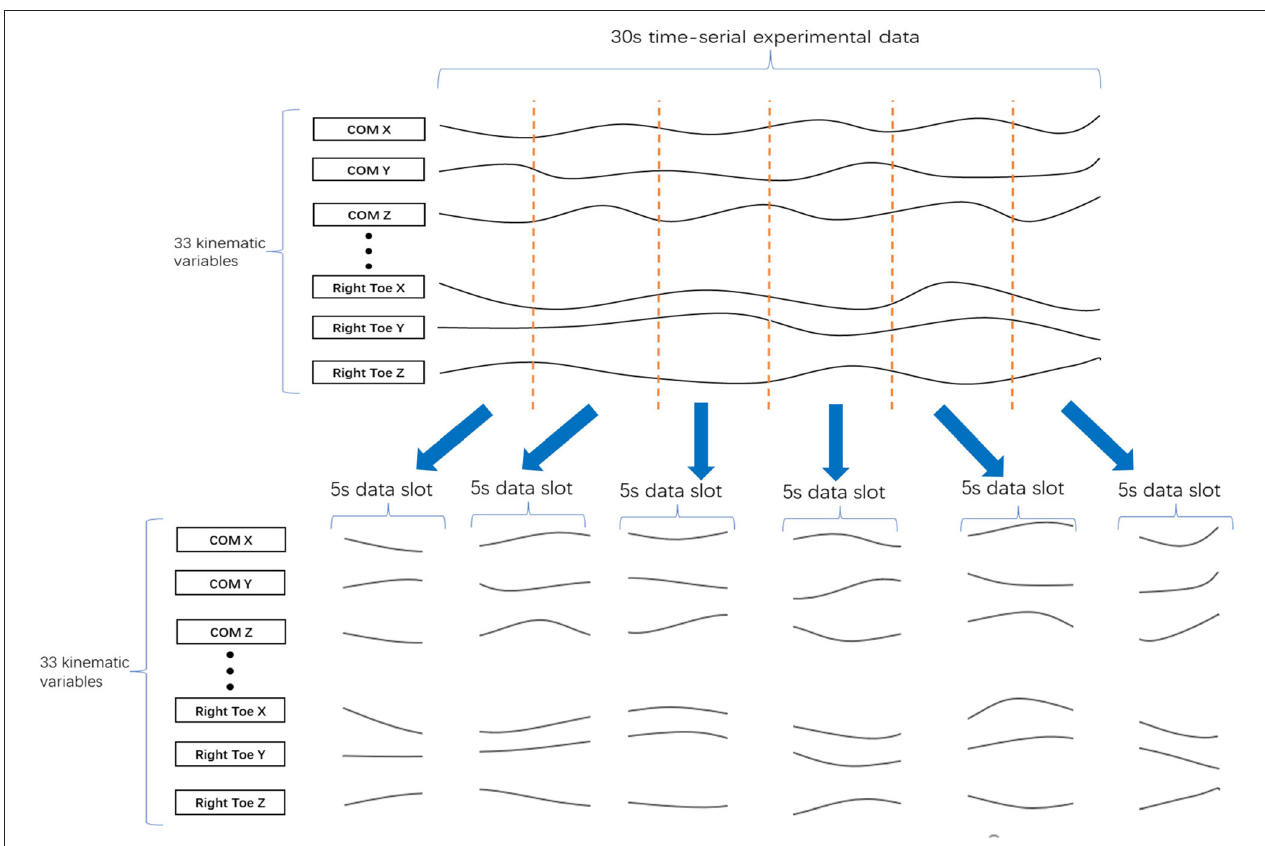
FIGURE 4 | Division of 30 s of data into six 5-s data slots. A 30 s set of experimental data with 33 kinematic variables was divided into six of 5-s data slots, where each data slot has 33 kinematic